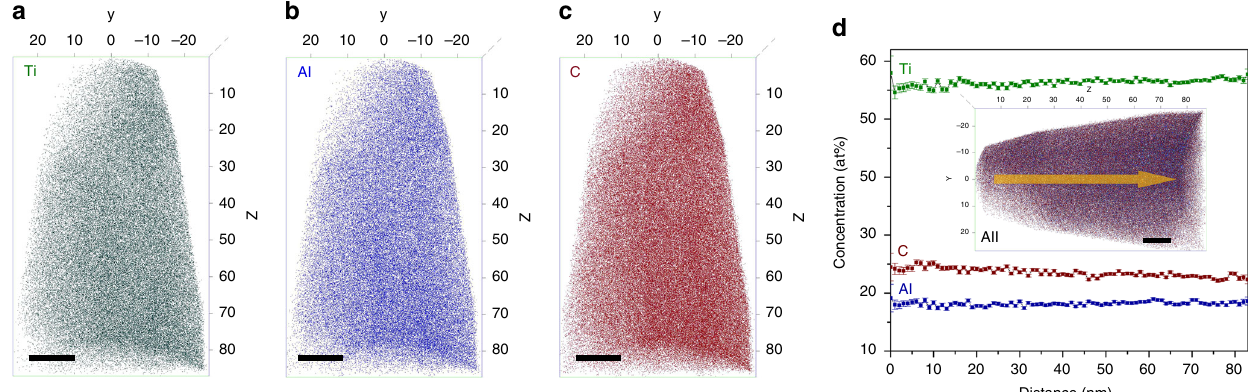
Fig. 3 Chemical distribution in fcc-(Ti 3 Al)C 2 solid solution. a – c Elemental maps of Ti 3 AlC 2 after irradiation at 4 × 10 16 cm − 2 showing homogeneous distribution of Ti, Al, and C elements. d Concentrations of these elements as a function of depth, which shows uniformly chemical distribution and proves the existence of Al in the irradiated sample. The scale bars on the APT images correspond to 10 nm